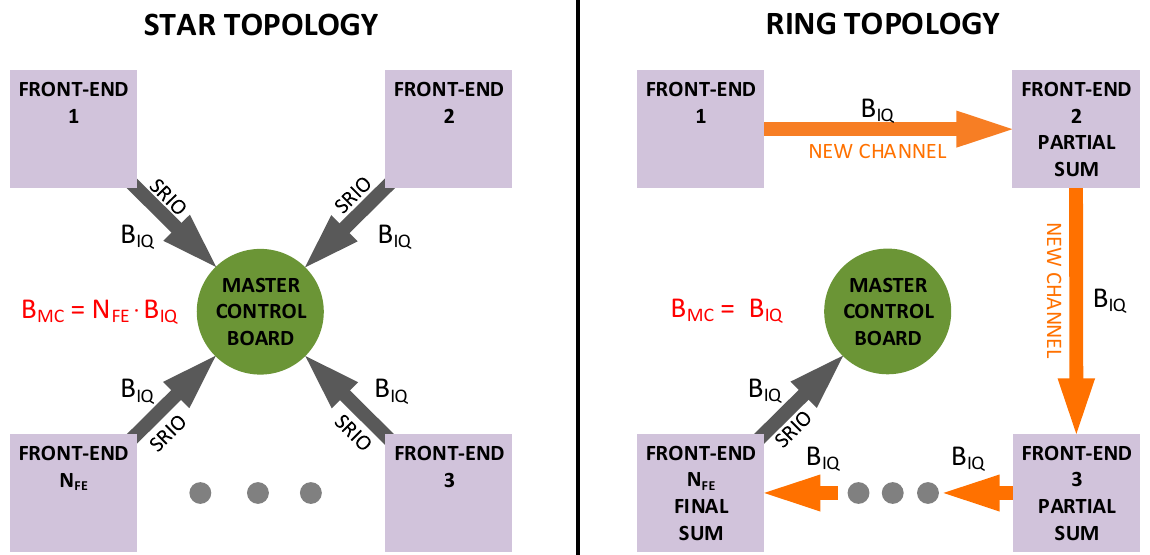
Figure 2. Schematic diagrams of the star ( left panel ) and ring data transfer configurations ( right panel ). In the star topology, all the FE boards send the beamformed lines to the MC board at the same time, so that the B MC requested to sustain the transfer is N FE times higher than the output bandwidth of each FE (B IQ ). In the ring topology each FE board sends the data to the neighbor board. The last FE board sends the final beamformed line to the MC board. The B MC requested to sustain the transfer is thus equal to the output bandwidth of a single FE board.